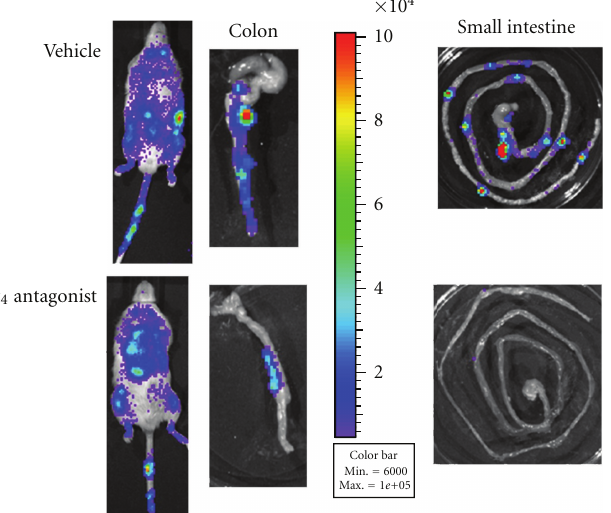
Figure 2: Inhibition of leukocyte migration by an α 4 integrin antagonist in experimental colitis. Leukocytes were isolated from mesenteric lymph nodes (MLNs) of β -actin luciferase mice and injected into recipient mice with dextran sodium sulphate- (DSS-) induced colitis. The recipient mice received vehicle or α 4 antagonist, 1 hour pre cell transfer. Whole body and organs ex vivo (colon and small intestine) were imaged using an IVIS 100 charge-coupled device imaging system 4 hours following transfer. The pseudocolored images represent light intensity, where red is the strongest, and violet is the weakest signal. Inhibition is detected in the colon and in Peyer’s patches of the α 4 antagonist-treated